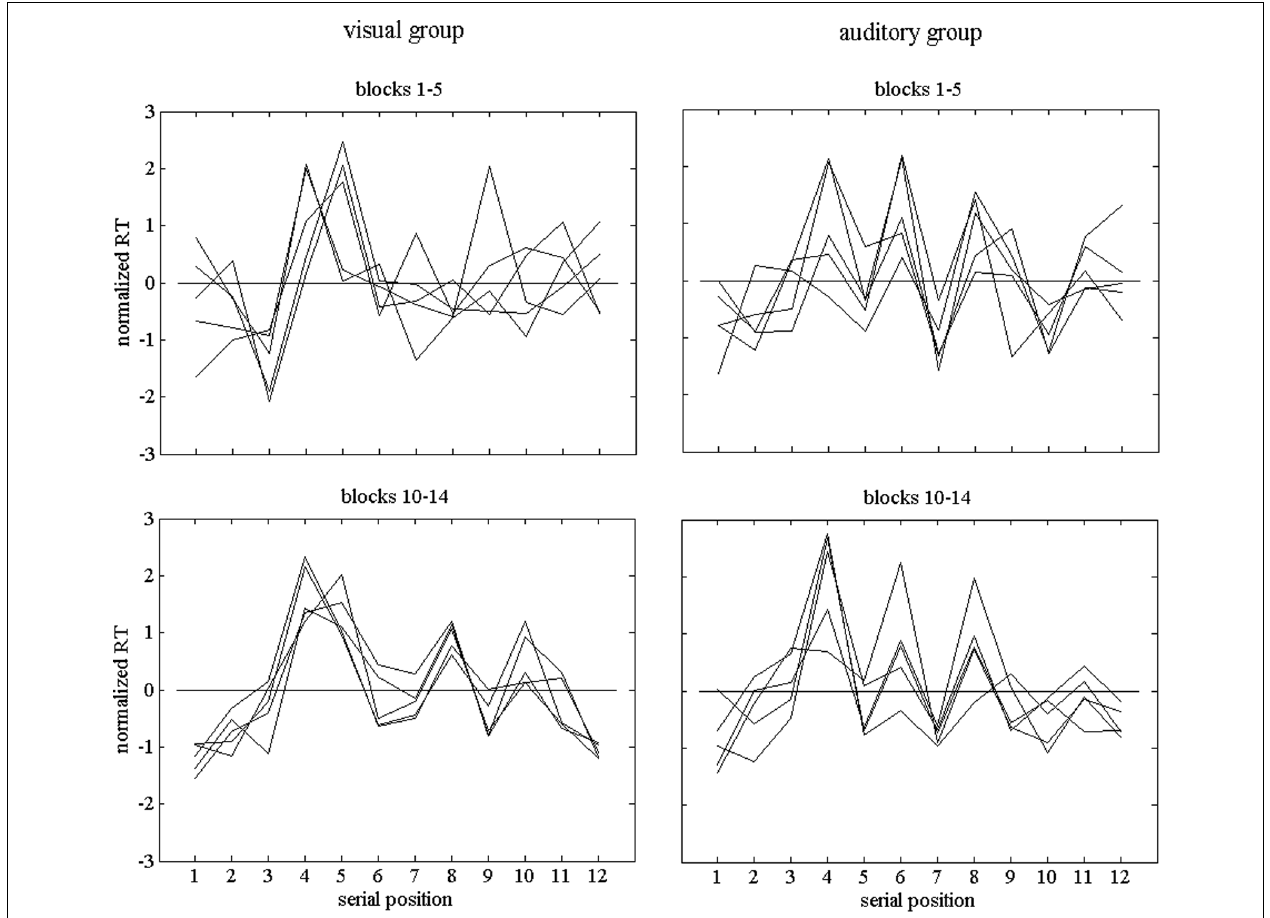
FIGURE 3 | Individual normalized response-time profiles of two participants, one of the visual group and one of the auditory group. The upper row of graphs shows profiles during early practice (Blocks 1–5) and the lower row shows profiles during late practice (Blocks